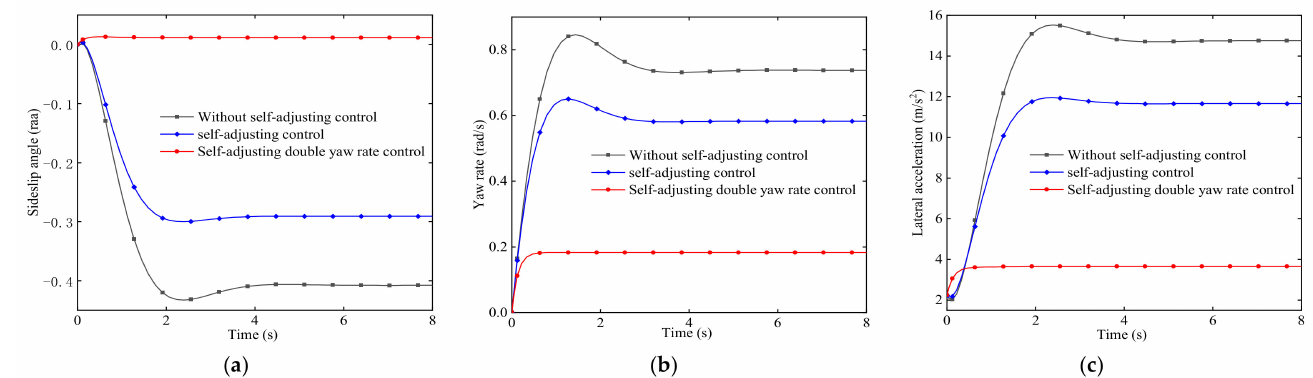
Figure 5. Membership function of input variable E, EC and output variable T.